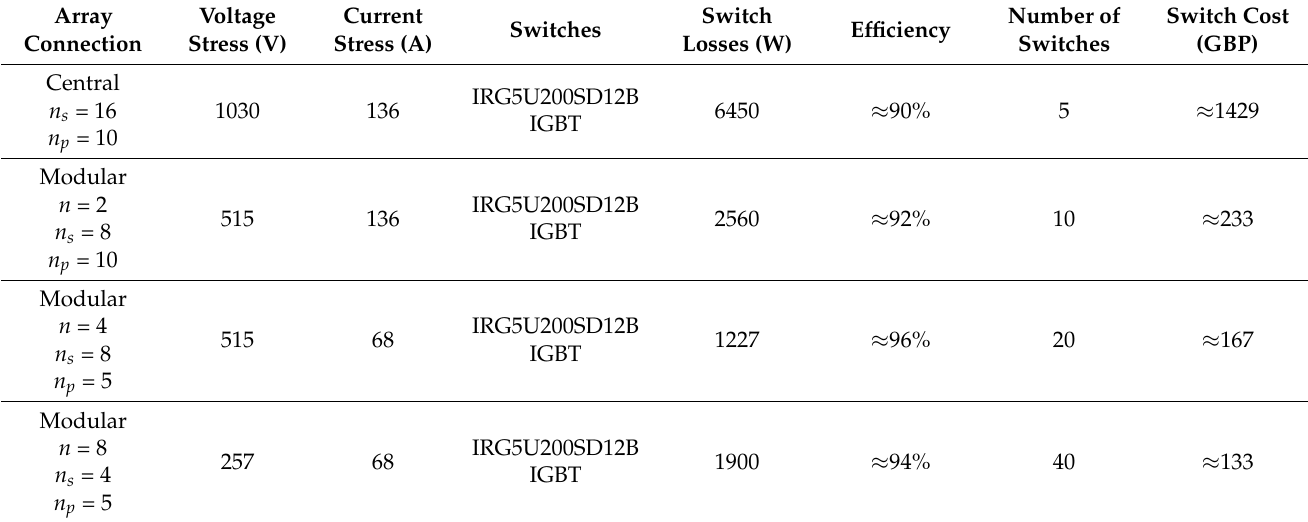
Table 4. Comparison between central-based and modular-based topologies at 32